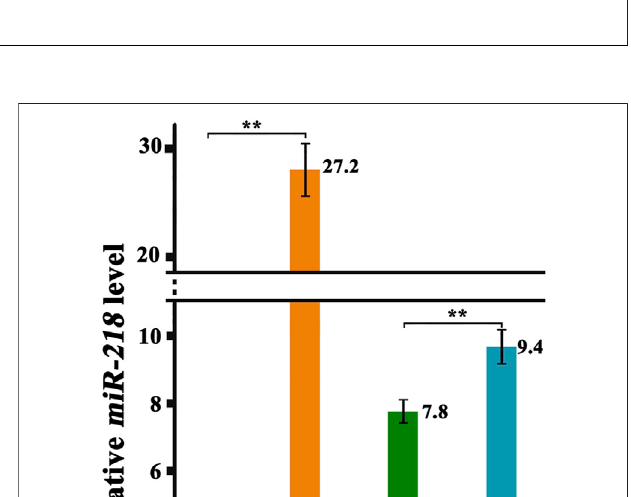
FIGURE4| Micrographs of fl uorescent, bright fi eld,and merged images of transfected ASCs after 24 and 48 h (scale bars = 20 μ m).